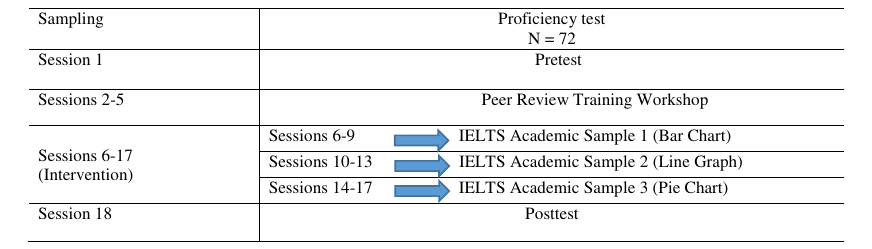
Table 2 The design of the